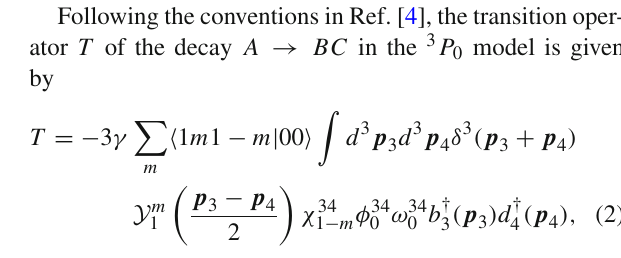
Table 1 The pseudoscalar states reported experimentally Isospin